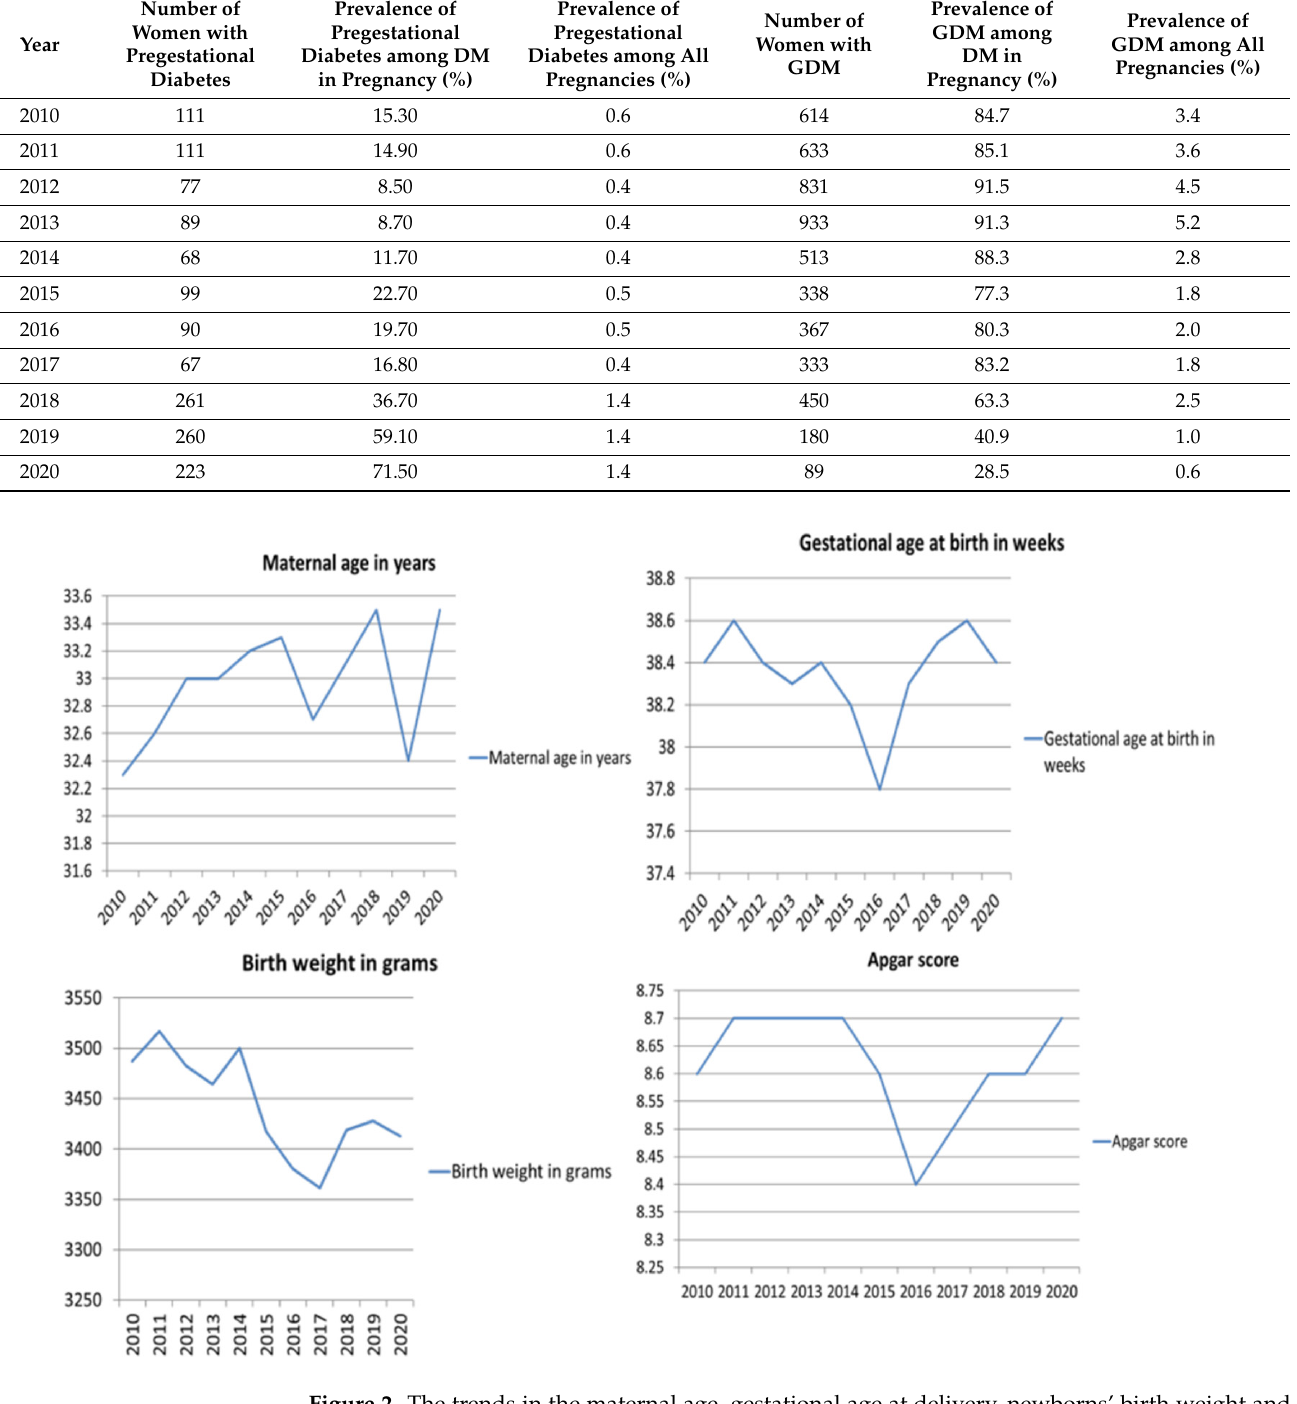
Table 1. The total number of women with pre-gestational diabetes and GDM and the prevalence of pre-gestational diabetes and GDM in each year of the study.